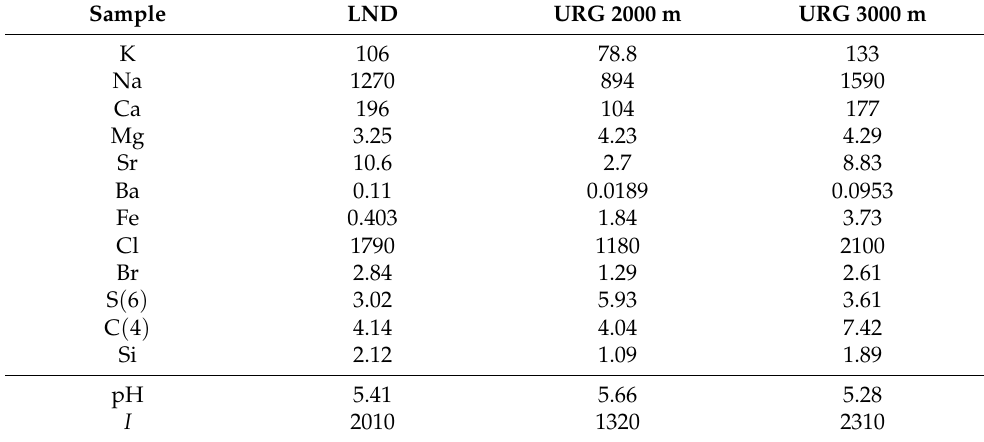
Table 1. Chemical compositions of the geothermal fluids samples given as total elemental concen- trations. All concentrations are given in (mM), except for pH. LND is a sample from the Landau geothermal reservoir [31]. URG 2000 m and URG 3000 m are averaged samples from the Upper Rhine Graben at respective depths [30]. The samples have been further modified to achieve equilibrium with respect to the common reservoir minerals barite, quartz, anhydrite, celestite, and calcite at reservoir conditions; chloride was fitted to reach charge balance [1].